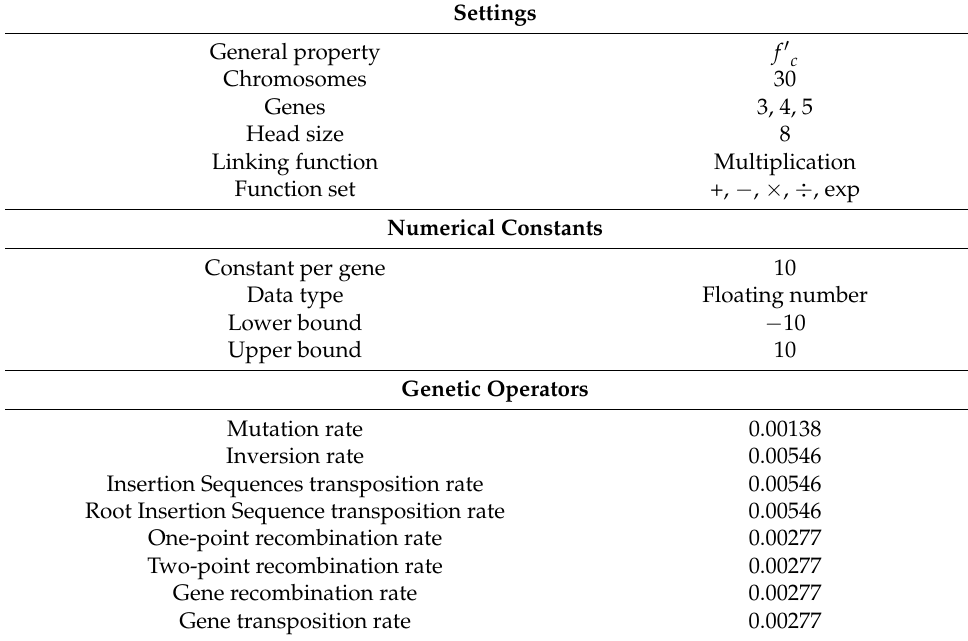
Table 5. Gene expression programming variables detail